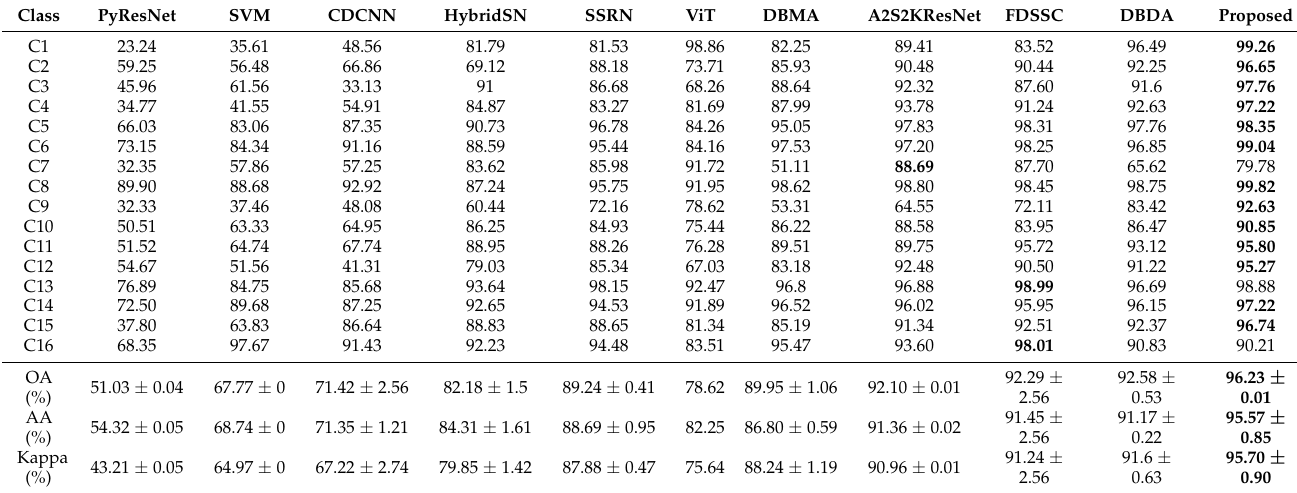
Table 5. KPIs (OA, AA, and kappa) on the Indian pines (IN) dataset with 3% training